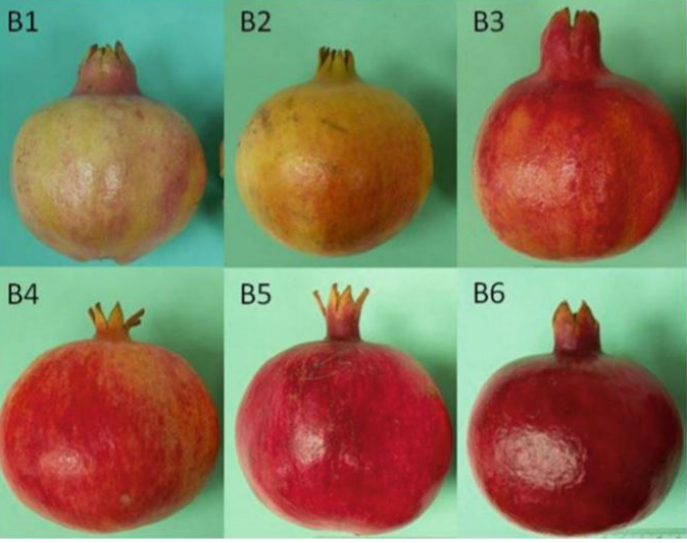
Figure 1. Ripening stages of pomegranate fruit according to Holland and Bar-Ya’akov’ [37]. Physical characteristics of whole fruit were measured on a representative sample